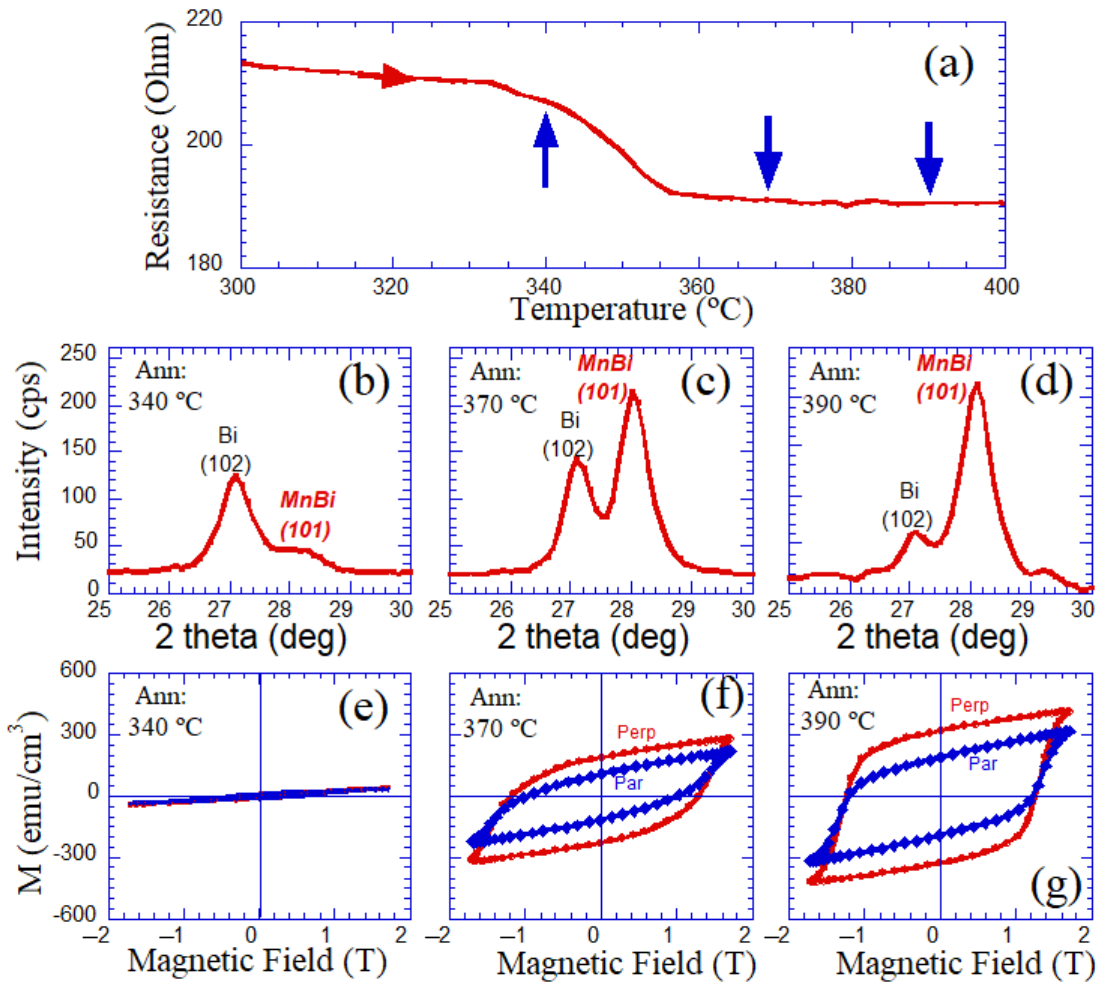
Figure 2. Resistance as a function of the temperature of the Mn(65%)Bi(35%) sample ( a ). The blue arrows over the resistance curve indicate the annealing temperatures. The red arrow indicates that the resistance was measured on increasing the temperature. X-ray diffraction patterns ( b – d ) and room-temperature magnetic hysteresis loops ( e – g ) of the 340, 370 and 390 ◦ C annealed Mn(65%)Bi(35%) samples, respectively. Par and Perp indicate the parallel and perpendicular orientation of the magnetic field with respect to the film plane.